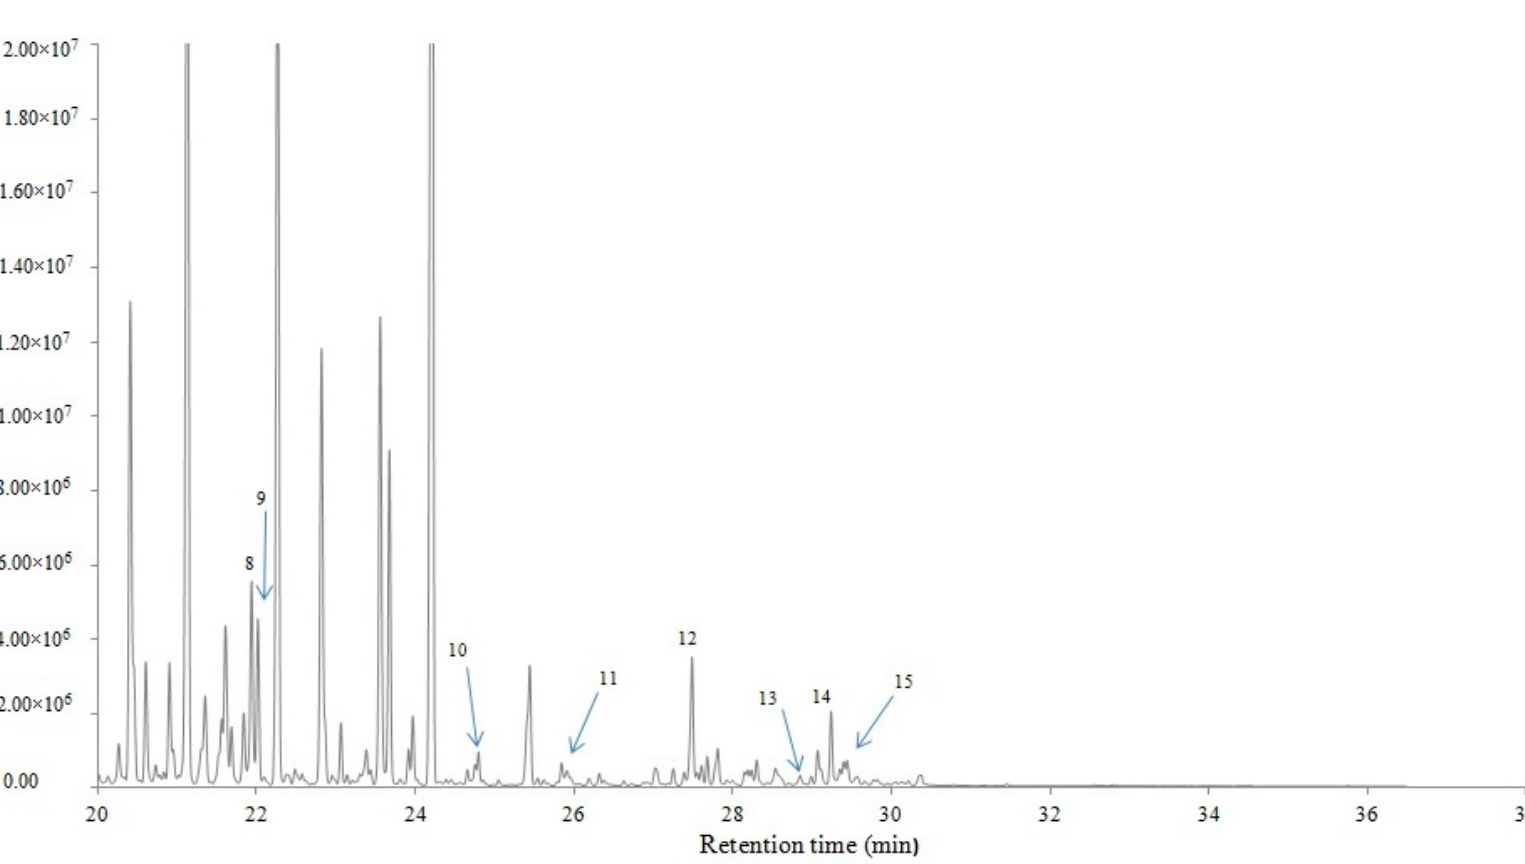
Figure 3. A typical gas chromatogram of Lavandula stoechas . Indicative volatile compounds (markers) are numbered according to the retention time shown in Table 2. 1: alpha-Pinene, 2: alpha-Fenchene, 3: Camphene, 4: para-Cymene, 5: cis-Linalool oxide, 6: alpha-Thujone, 7: Camphor, 8: alpha-Terpineol, 9: Myrtenal, 10: cis-Geranyl acetate, 11: (+)-Sativene, 12: beta-Selinene, 13: Viridiflorol, 14: (+)-Aromadendrene.